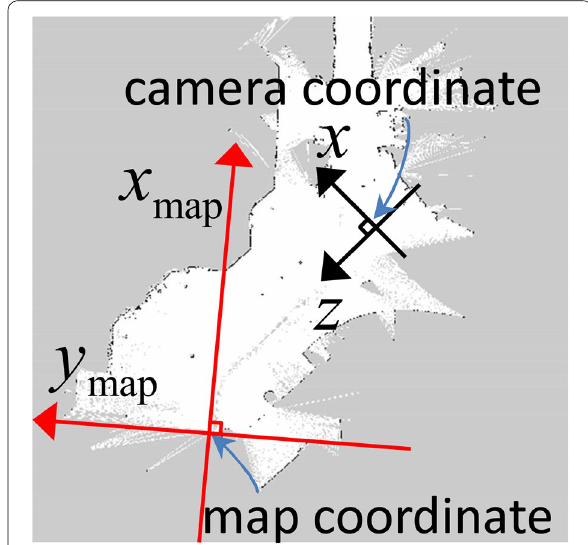
Fig. 23 Grid-based map with coordinate systems used in our robot navigation system